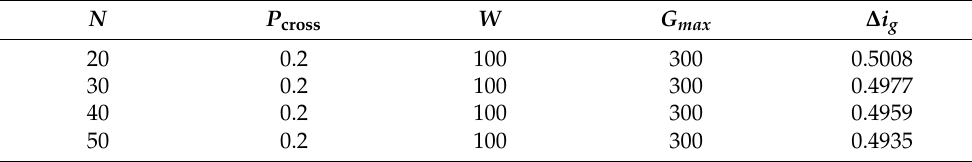
Table 4. Obtained results from the sensitivity test considering G =